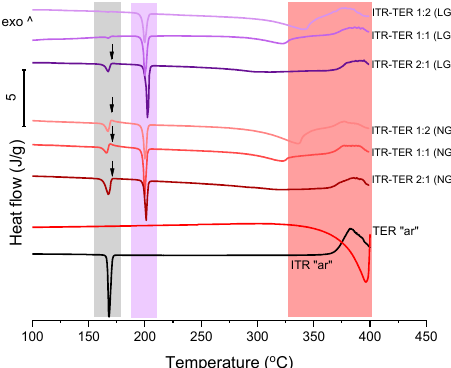
Figure 2. Powder X-ray diffraction (PXRD) of the ITR and TER starting material as the received powders (“ar”) and binary ITR and TER mixtures following neat grinding (NG) and liquid-assisted grinding (LG). * Indicates the distinct peak of the new phase (cocrystal), broken black lines show the position of the ITR diffraction peaks, while the broken red lines show the position of the TER diffraction peaks.